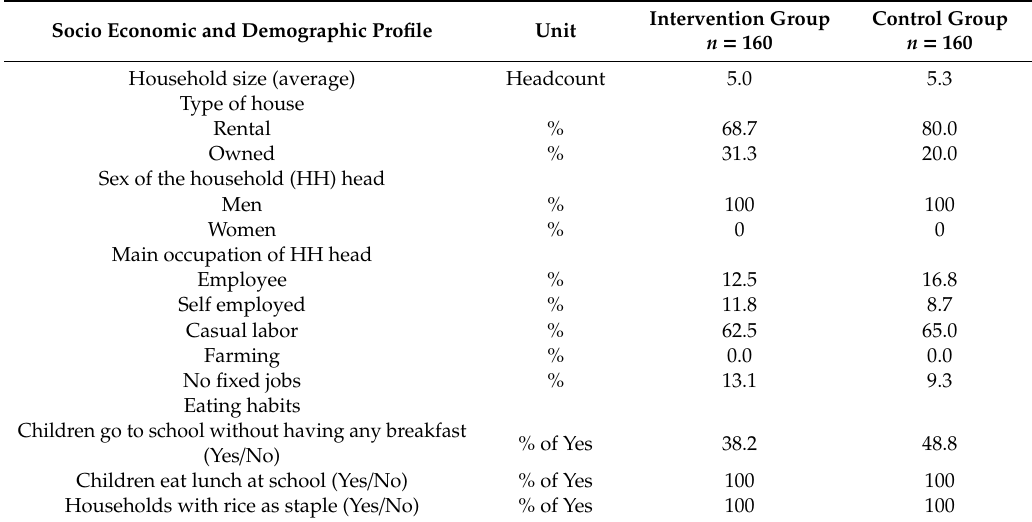
Table 1. Socioeconomic and demographic profile of households of the sample children.